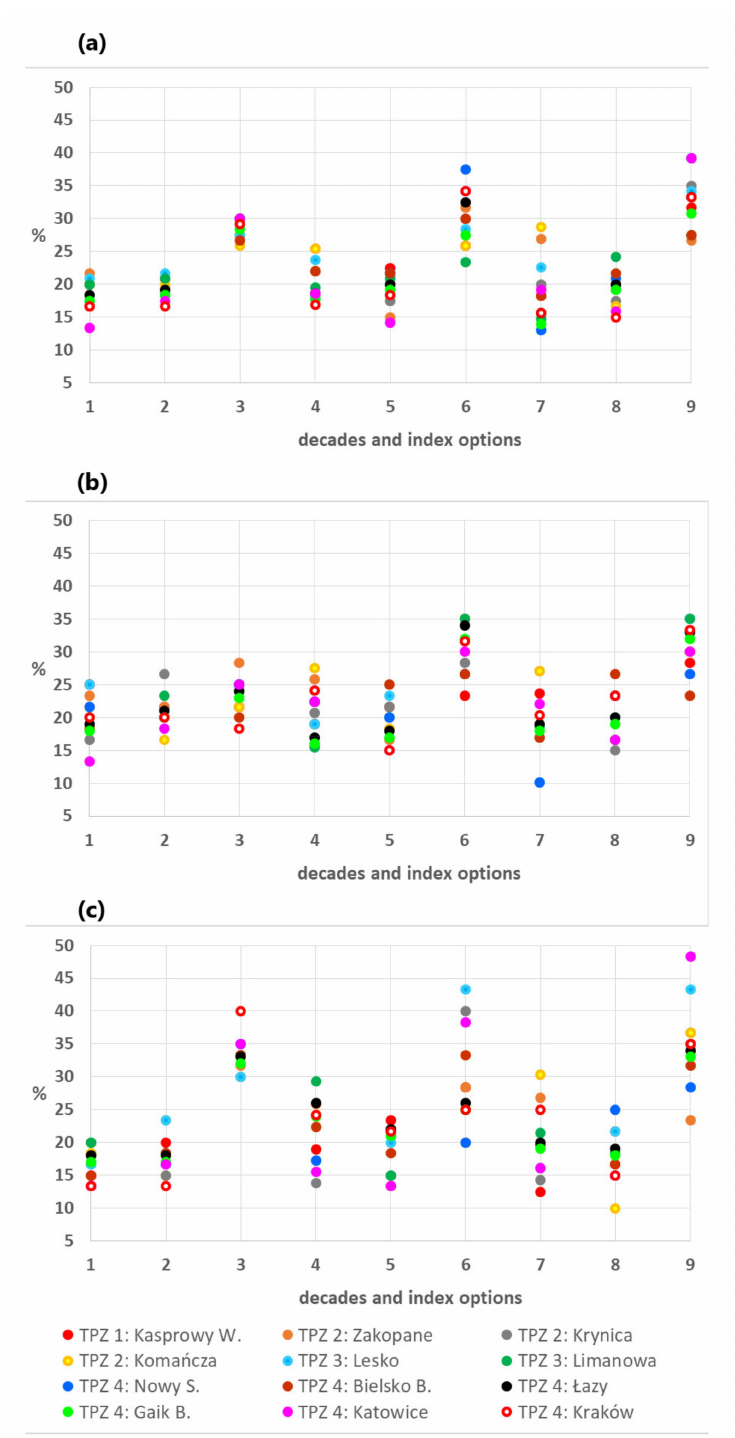
Figure 8. Percentage of dry months according to SPEI (SPEI ≤ − 0.8) for 1-, 3- and 6-monthly timescales, for the whole year ( a ) and for the subperiods May–October ( b ) and November–April ( c ) in the decades of the study period. Stations are ordered following the concept of TPZ explained in Section 4.1. Explanation of numbers on axis x: 1—1991–2000, 1 month; 2—2001–2010, 1